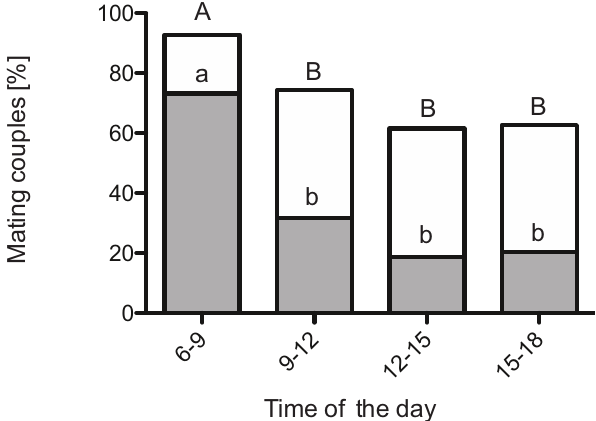
Figure 2. Diurnal mating activity of 4-d-old virgin Drosophila suzukii during four time intervals of a 12 h photoperiod. The highest percentage of mating flies was observed early in the morning, immediately after onset of the photophase. The subsections of the bars (grey) illustrates the mating events during the first 30 min of each 3 h time interval. Different letters indicate significant differences (Tukey’s multicomparison test, p < 0.01) within 30 min periods (lowercase letters) and within 3 h periods (capital letters).